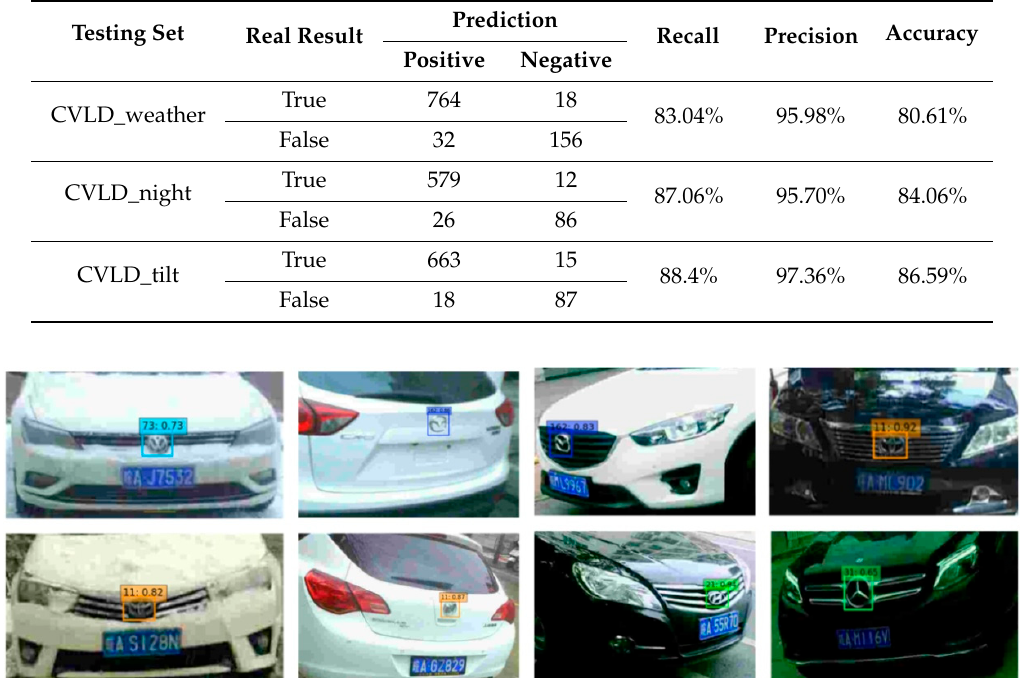
Table 9. Performance on di ff erent testing sets.